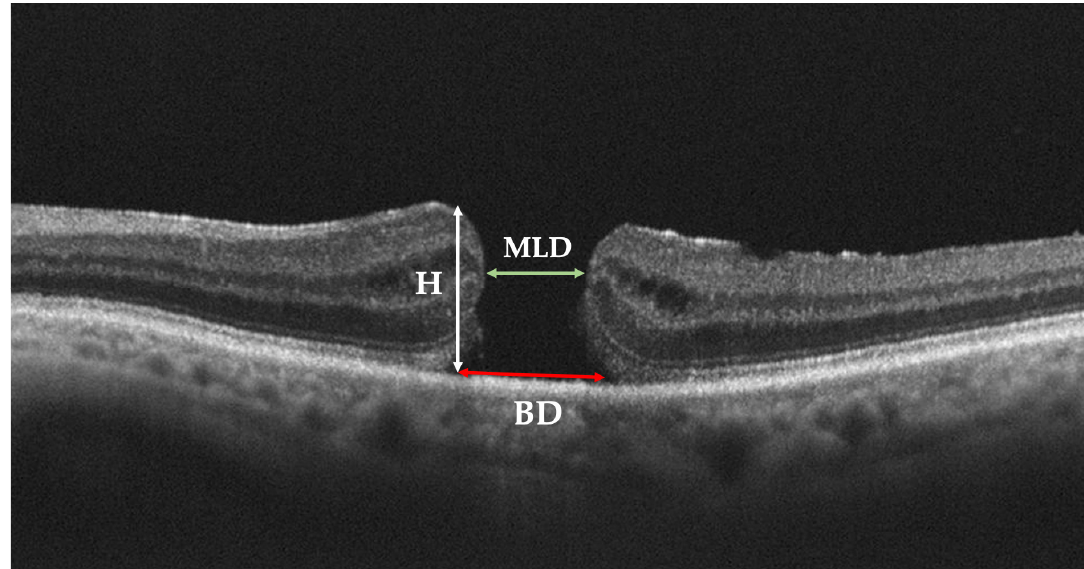
Figure 1. Preoperative parameters of full-thickness macular hole (FTMH) on Optical Coherence Tomography (OCT) scan. Minimum linear diameter (MLD), base diameter (BD), and hole height (H) are shown.